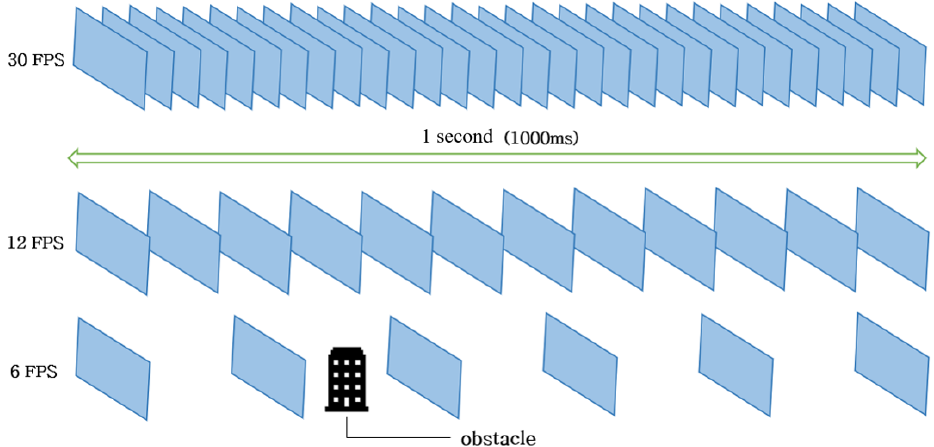
Figure 1. An example of the frames per second. The frames of detection per second is referred to as FPS, and if detection is processed at 30 frames per second, this is referred to as 30